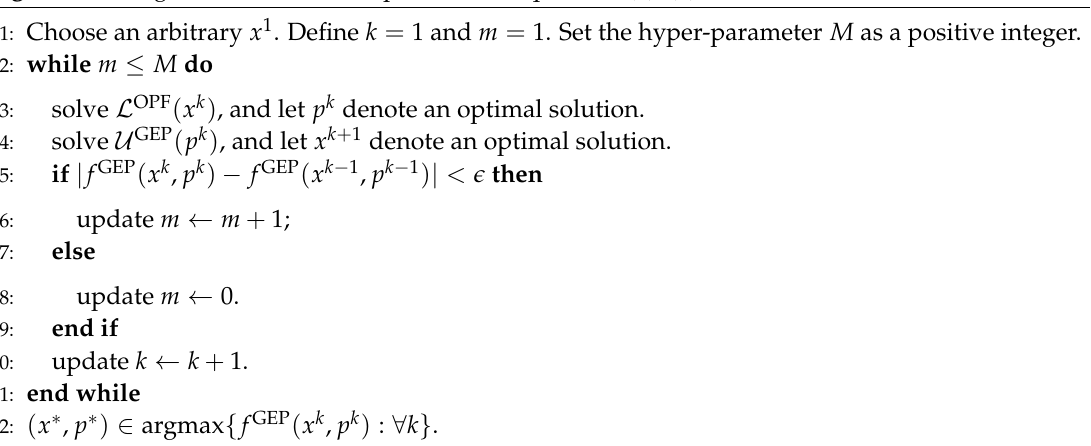
Algorithm 1 Algorithm for the GEP problem in Equations